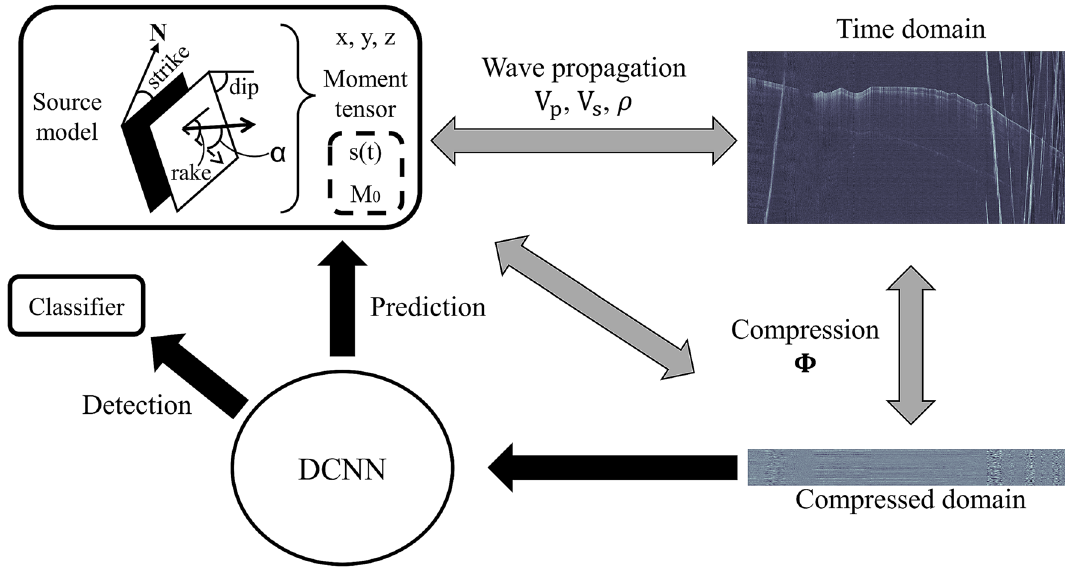
Figure 2. Illustration of deepCoSeL principles. Grey double arrows denote unique correspondences. Since the source model parameters have a unique correspondence with the compressed seismograms, a DCNN can be trained to connect the compressed data to the source model (or a detection classifier). Source parameters within the dashed rectangle have not yet been attempted to recover with deepCoSeL. The number of recoverable source parameters depends on the properties of the time domain traces. For example, removing polarity information before compression would only allow to recover source